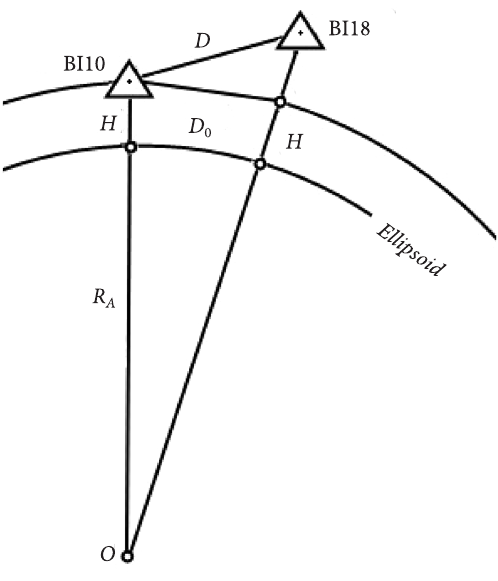
Figure 3. Base station BI18 of O. P. Suchkov SSB with GNSS equipment placed upon